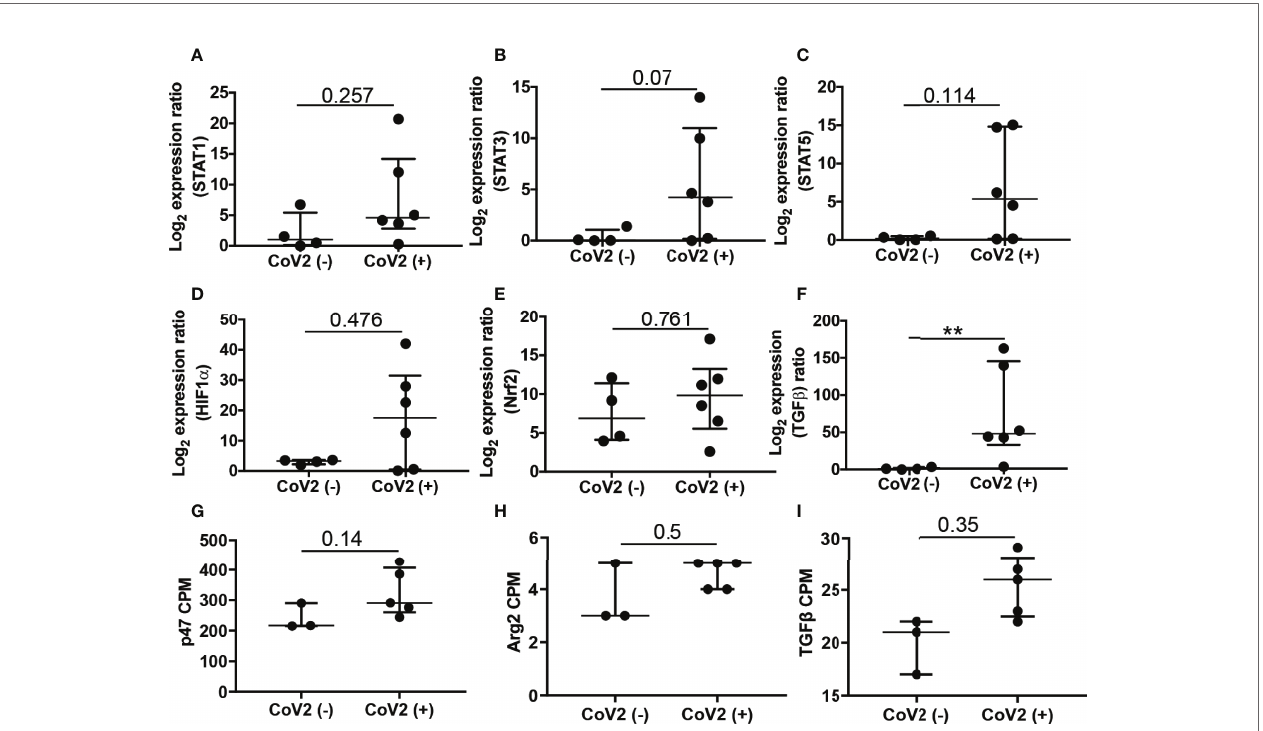
FIGURE 6 | Expression of genes associated with expansion and function of M-MDSC: Freshly isolated PBMC from CoV2- and CoV2+ individuals were stained with anti-CD14 and -HLA DR antibodies; CD14 + HLA DR -/lo M-MDSC were sorted by fl ow cytometry and stored in Trizol. (A – F) RNA was isolated and the expression of indicated genes was determined by qRT PCR as detailed in Methods . (G – I) Expression of indicated genes was plotted from RNA-Seq data, as counts per million (cpm). For all, each dot in the plots depicts data of each individual donor, the plots include observations from 25 th to 75 th percentile. The horizontal line represents the median value. p-values are shown, **p < 0.005; nominal p-values are indicated for the RNA-Seq